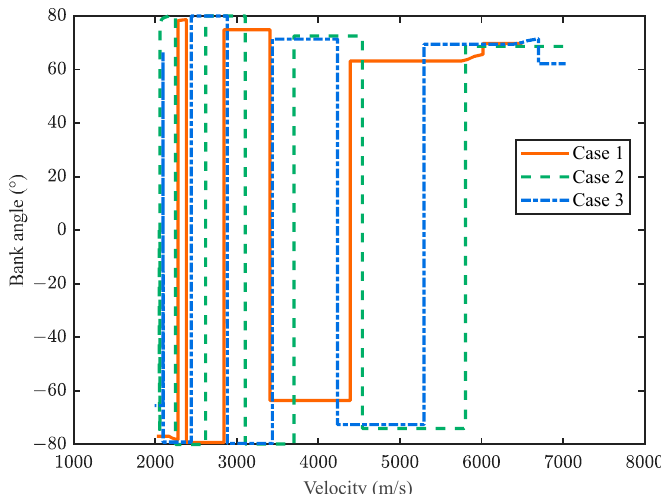
Figure 21. Velocity histories of the bank angle.